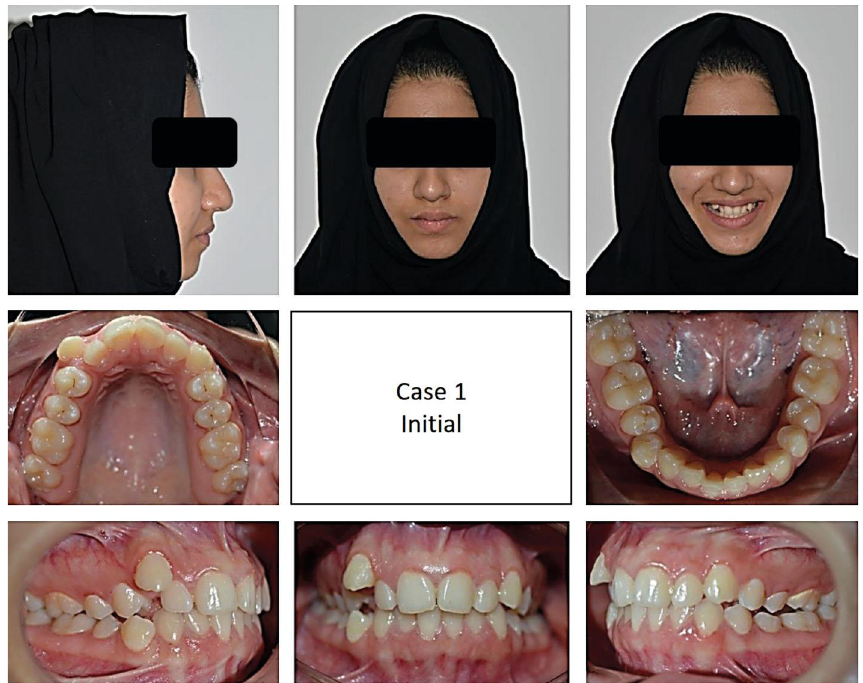
Figure 1: Pretreatment extraoral and intraoral photographs of the